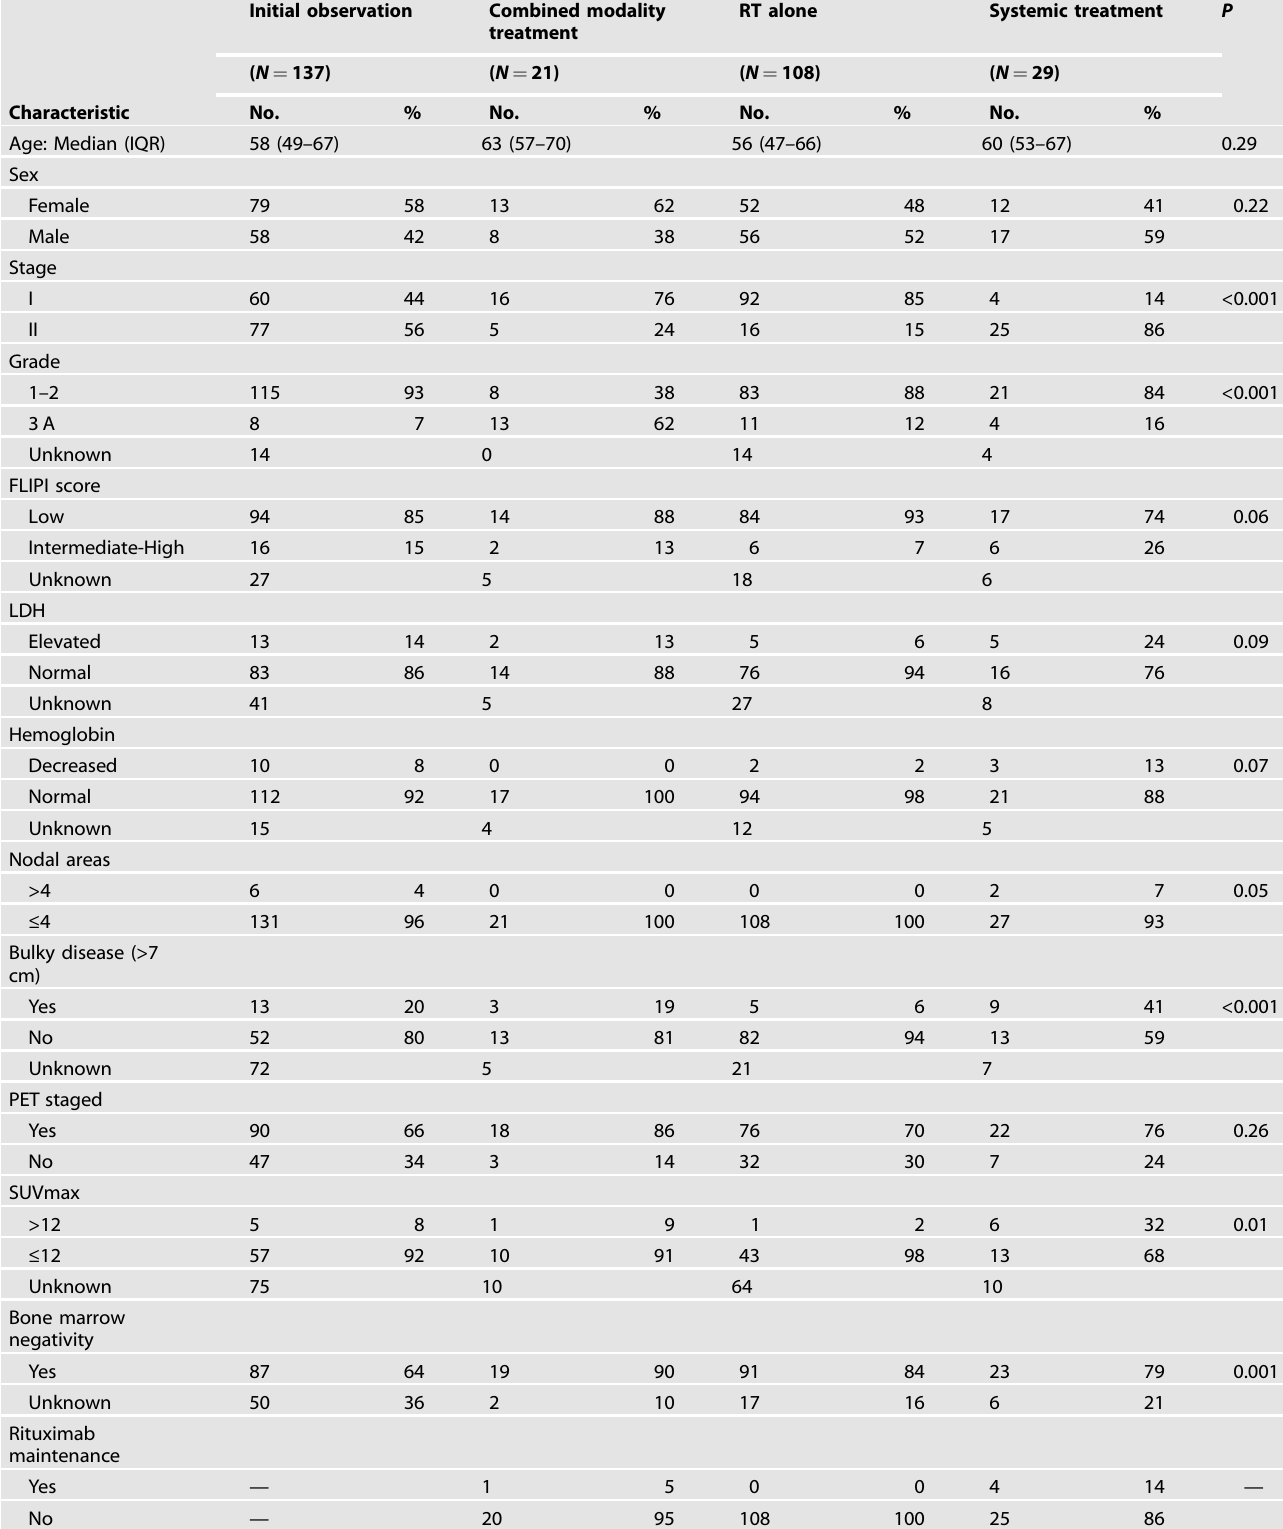
Table 2. Baseline characteristics based on management